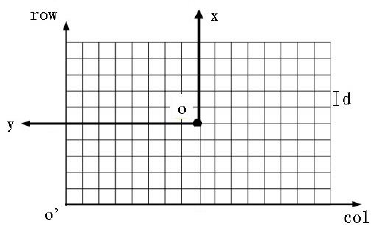
Figure 2. The image plane coordinate system and pixel coordinate system When all of the parameters in equation (1) are known, the projection p of a ground point P can be determined. Given the relationship between the image plane coordinate system o-xy and the pixel coordinate system o’-colrow shown in Figure 2, the position of p under o’-colrow can be determined by equation